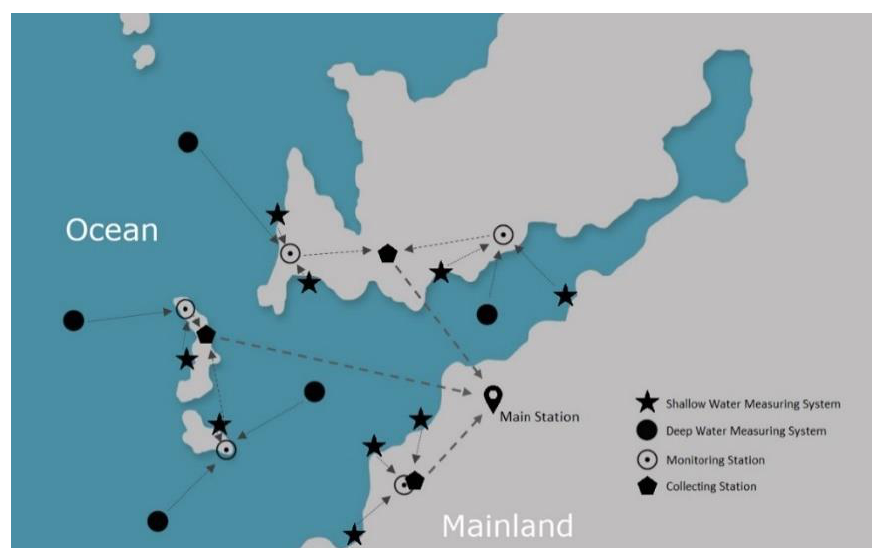
Figure 3. Representation of a hypothetical wireless communication network for ocean water quality monitoring using both short- and long-range communication protocols.